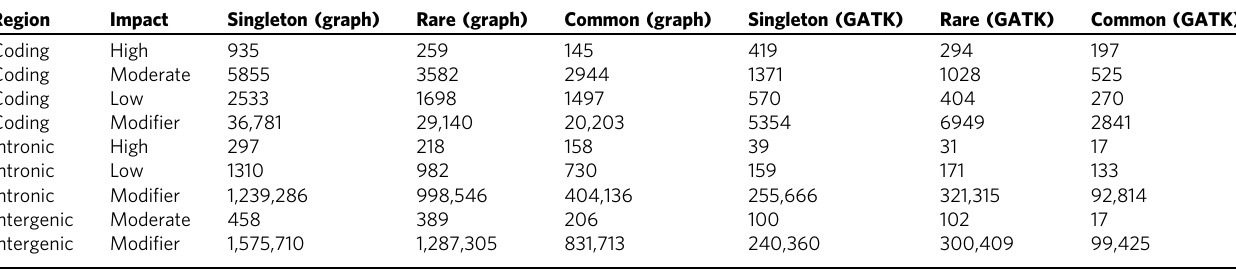
Table 1 Functional impact of detected variants that are unique to each pipeline.